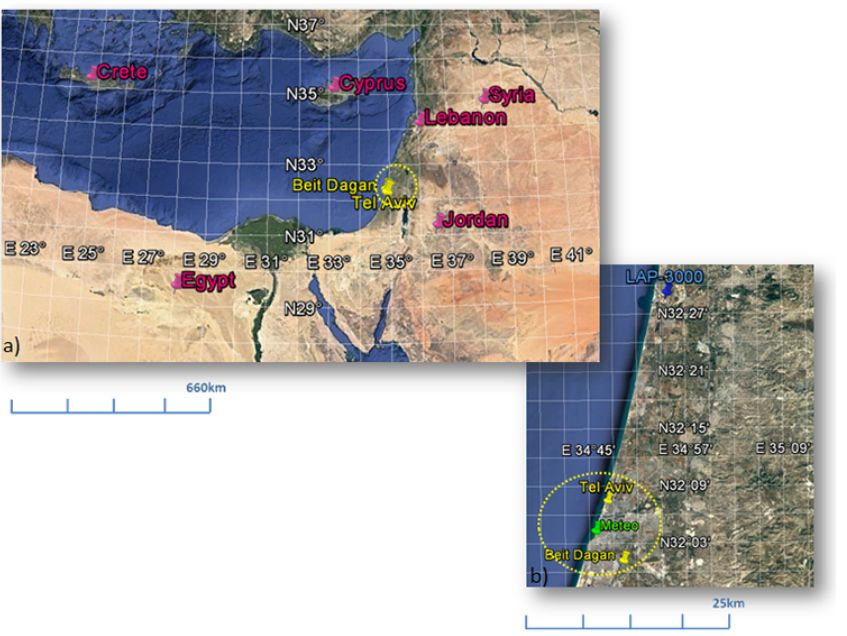
Figure 1. Google Earth map of the eastern Mediterranean, with indication of the ceilometers in Tel Aviv and Beit Dagan (a) . Zoomed-in image with indications of the LAP-3000 acoustic radar site and the onshore meteorological monitoring station (b)